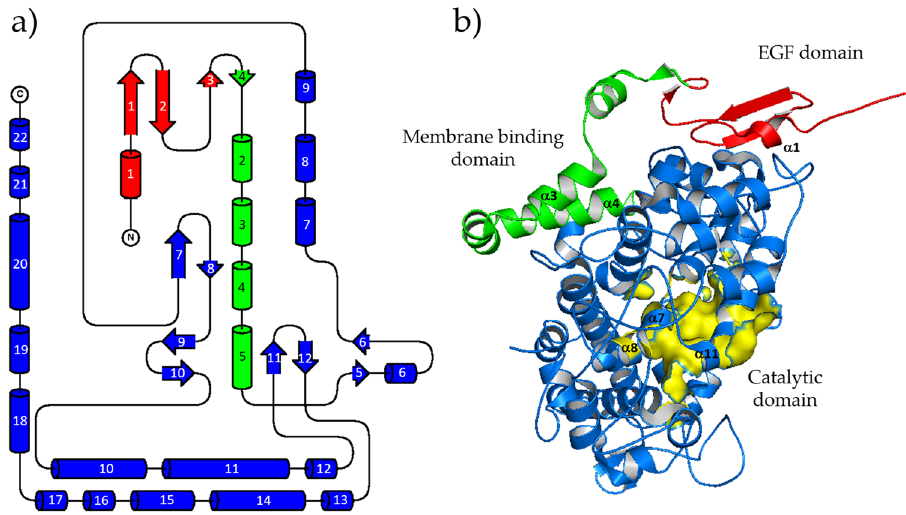
Figure 3. h COX-1 folding. ( a ) h COX-1 topology diagram: secondary structure elements are shown in red, green, and blue for EGF, membrane-binding domain, and catalytic domain, respectively. β-strands and α-helixes are shown as arrows and cylinders, respectively; ( b ) h COX-1 domains are shown in cartoon representation in the same color code of ( a ). Solvent excluded surface of the catalytic domain is in yellow color.